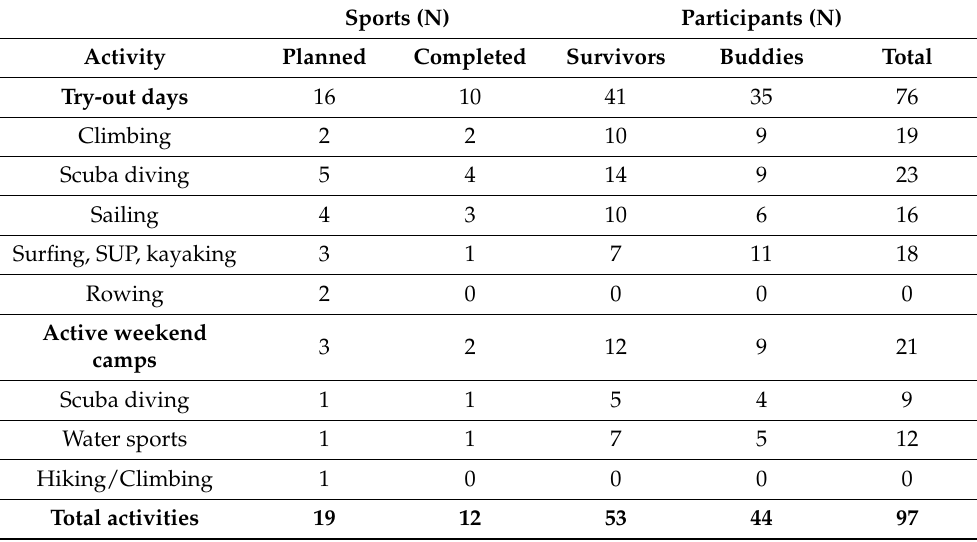
Table 2. Overview of sports and number of participants in 2019.